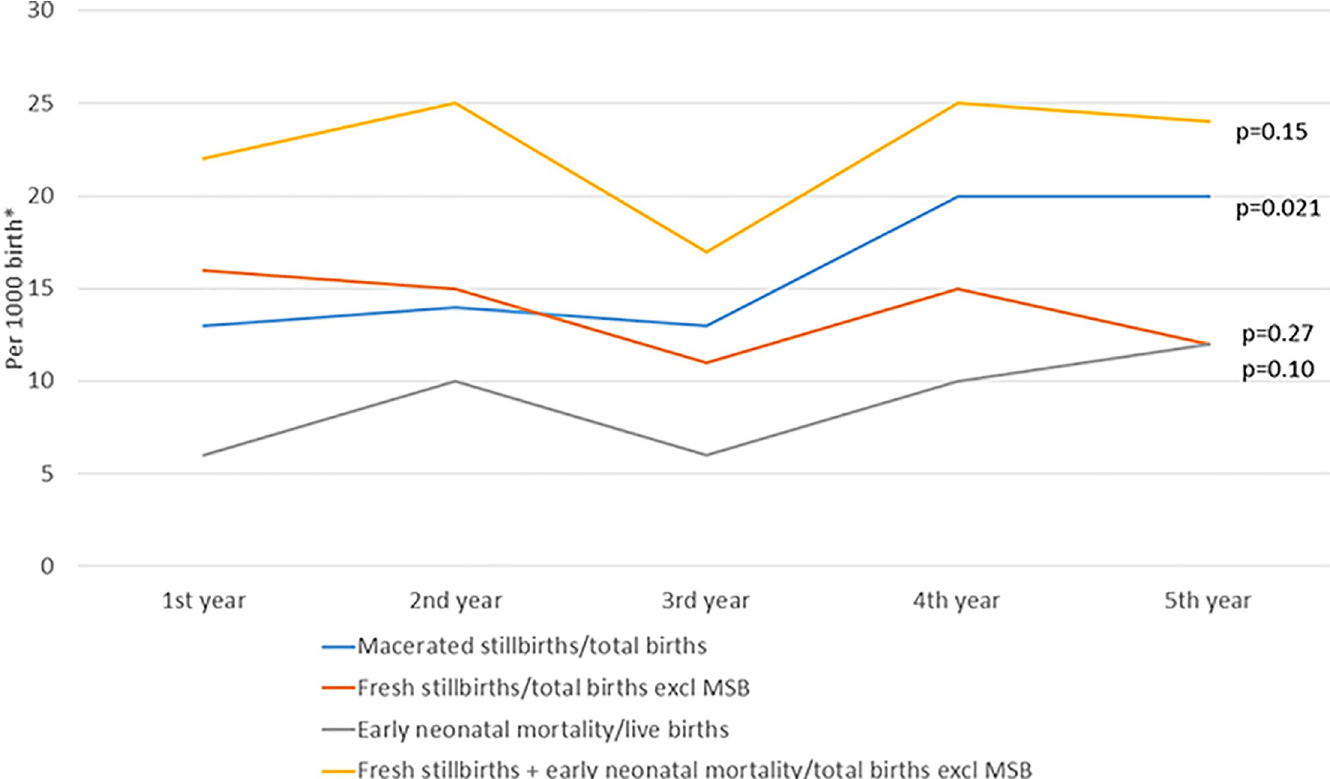
Fig 3. Early neonatal mortality and stillbirths at Haydom Hospital by year during 1.7.13 to 30.6.18.